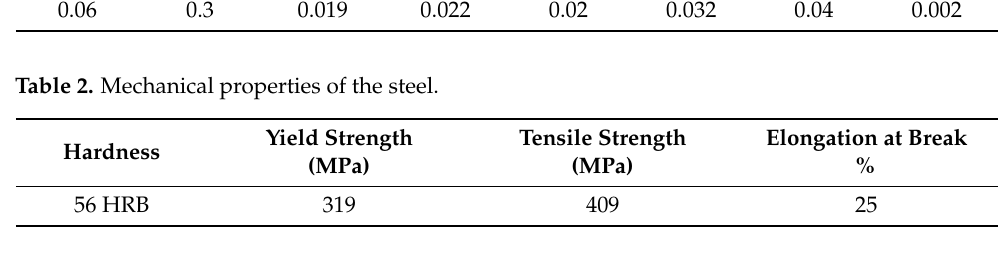
Table 3. Mechanical properties of Araldite 2015 [31].